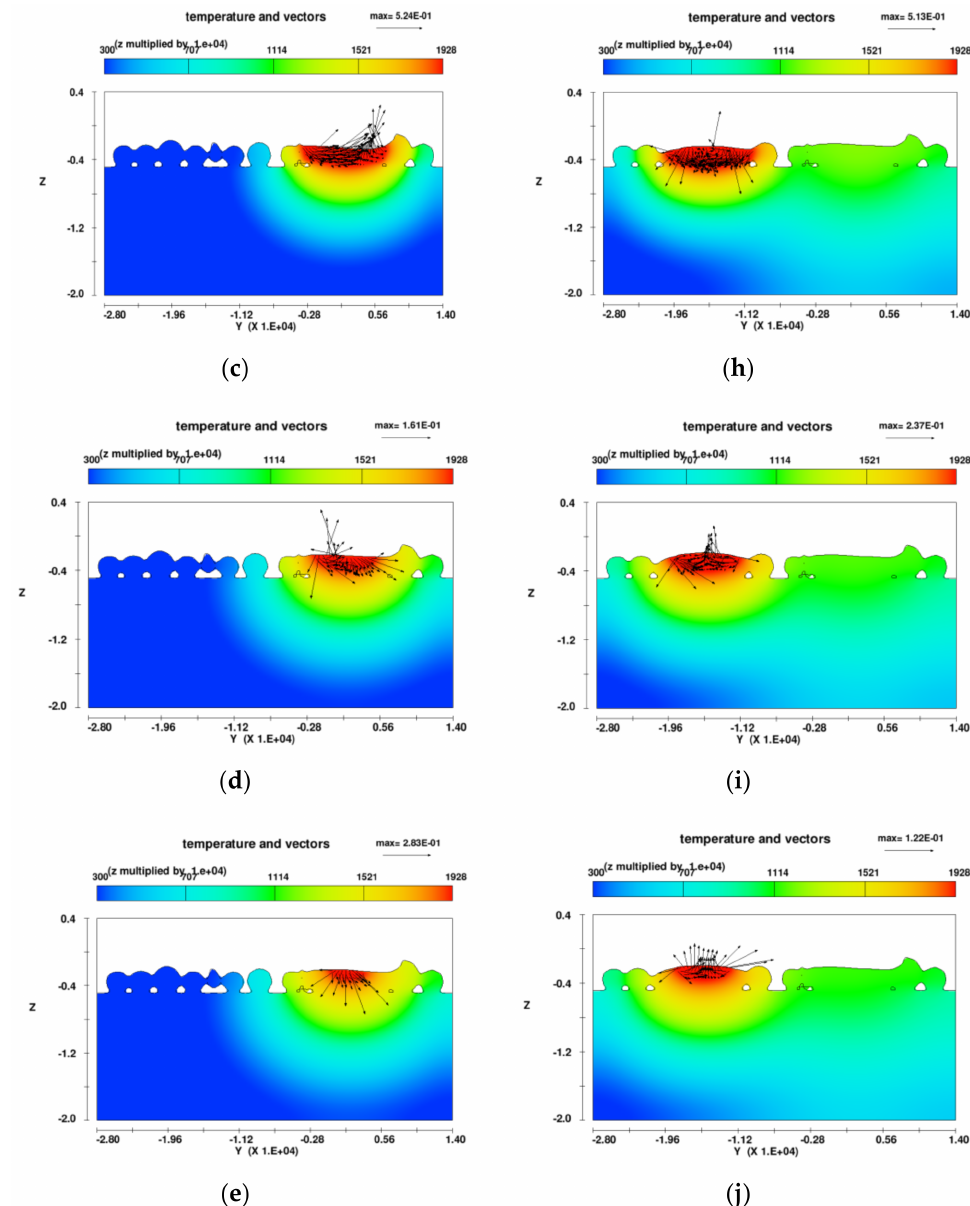
Figure 10. The change of the cross-sectional shape of the molten pool: ( a ) 1 × 10 − 4 s. ( b ) 2 × 10 − 4 s. ( c ) 3 × 10 − 4 s. ( d ) 4 × 10 − 4 s. ( e ) 5 × 10 − 4 s. ( f ) 6 × 10 − 4 s. ( g ) 7 × 10 − 4 s. ( h ) 8 × 10 − 4 s. ( i ) 9 × 10 − 4 s. ( j ) 10 × 10 − 4